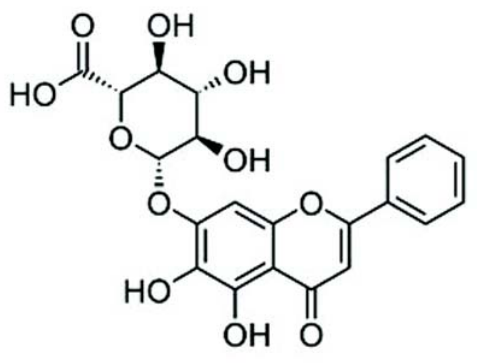
Figure 1. Chemical structure of